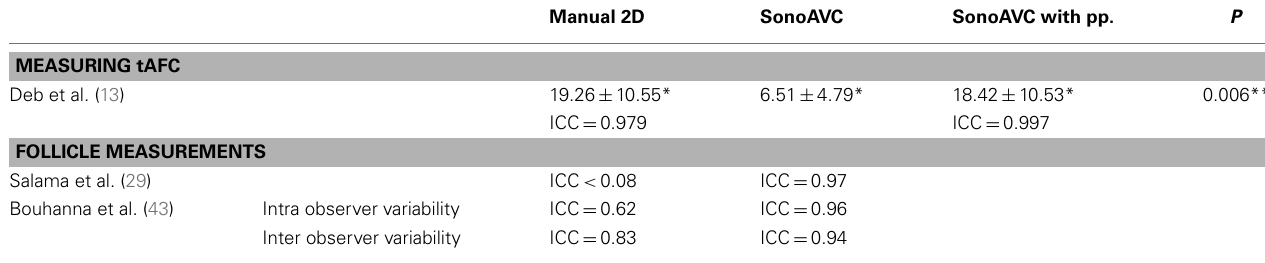
Table 3 | Investigation of operator independence